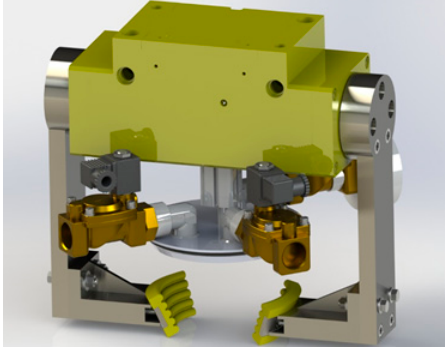
Figure 6. Device for grasping the casting bowl.